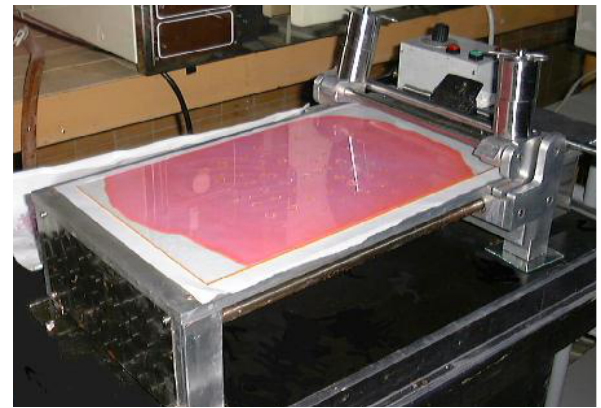
Figure 1. Photograph of the photopolymer material after its manufacturing.